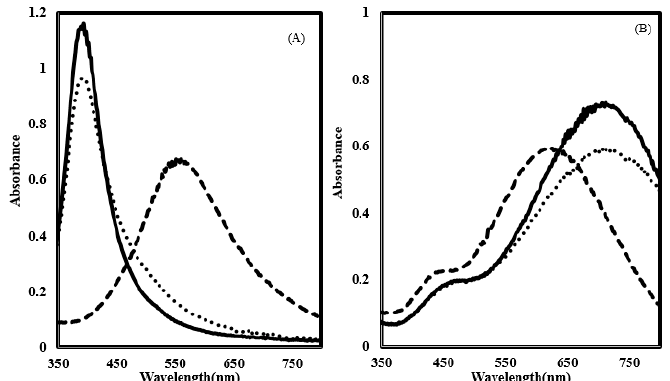
Figure 5. UV-vis absorption spectra of spherical and prismatic AgNPs stabilized with citrate (curve A and C ) and immediately after mixing with 5 mM phosphate buffer saline spiked with nutrient broth (curve B and D ), indicative of the aggregation of colloidal solution under assay conditions.